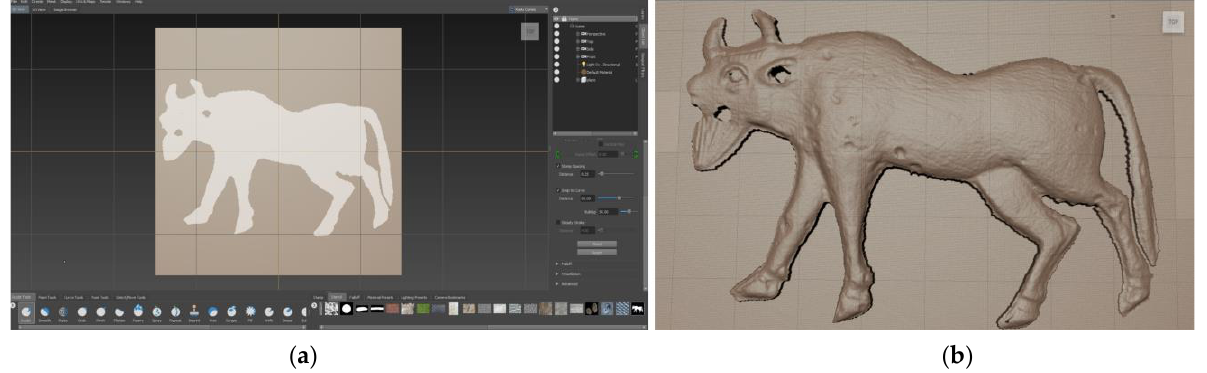
Figure 8. ( a ) Using the TIFF image generated via ray casting as a stencil tool; ( b ) The result of the displacement map applied to the plane to generate the ornament.